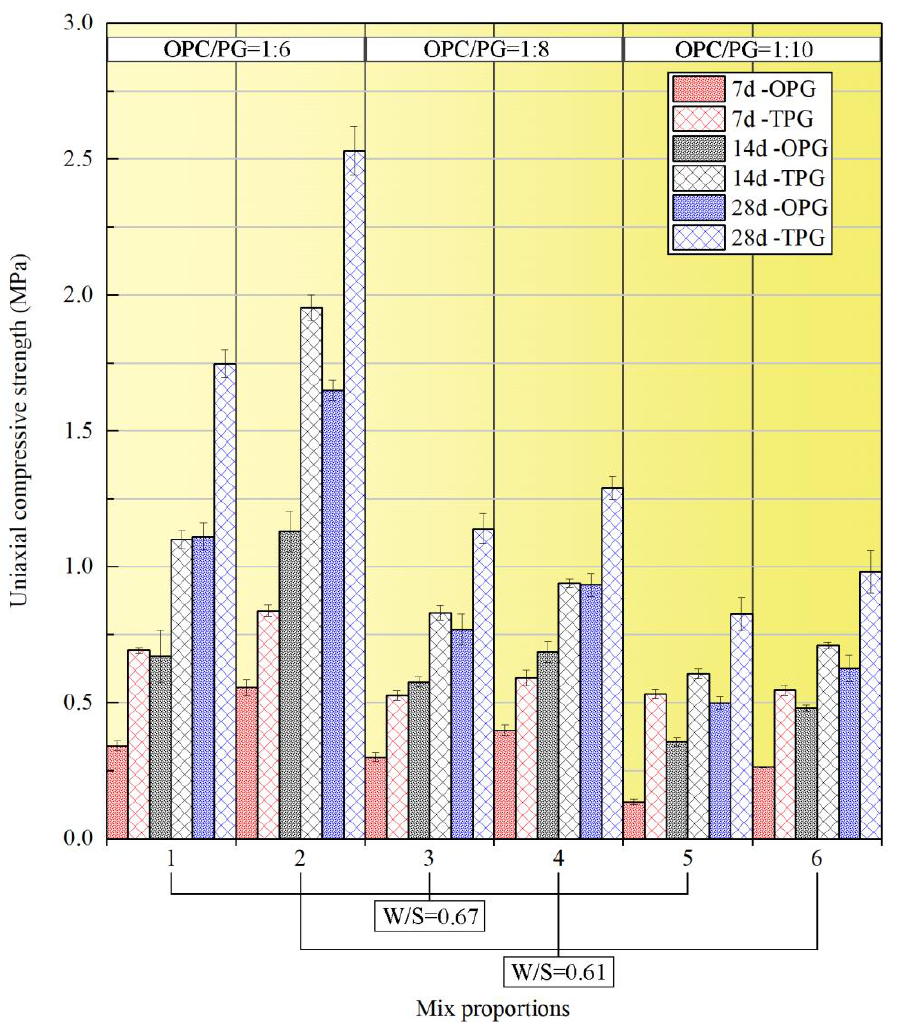
Figure 9. Uniaxial compressive strength (UCS) comparison of OPG-based CPB (OCPB) and treated PG (TPG)-based CPB (TCPB).